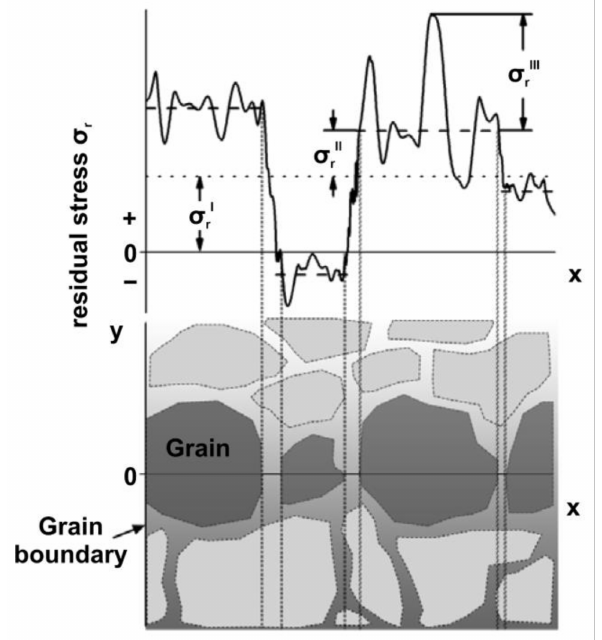
Figure 2. Schematic representation of the different types of RS within a polycrystalline material where σ I , σ II , σ III denote the type I, II and II stresses respectively. Adapted from